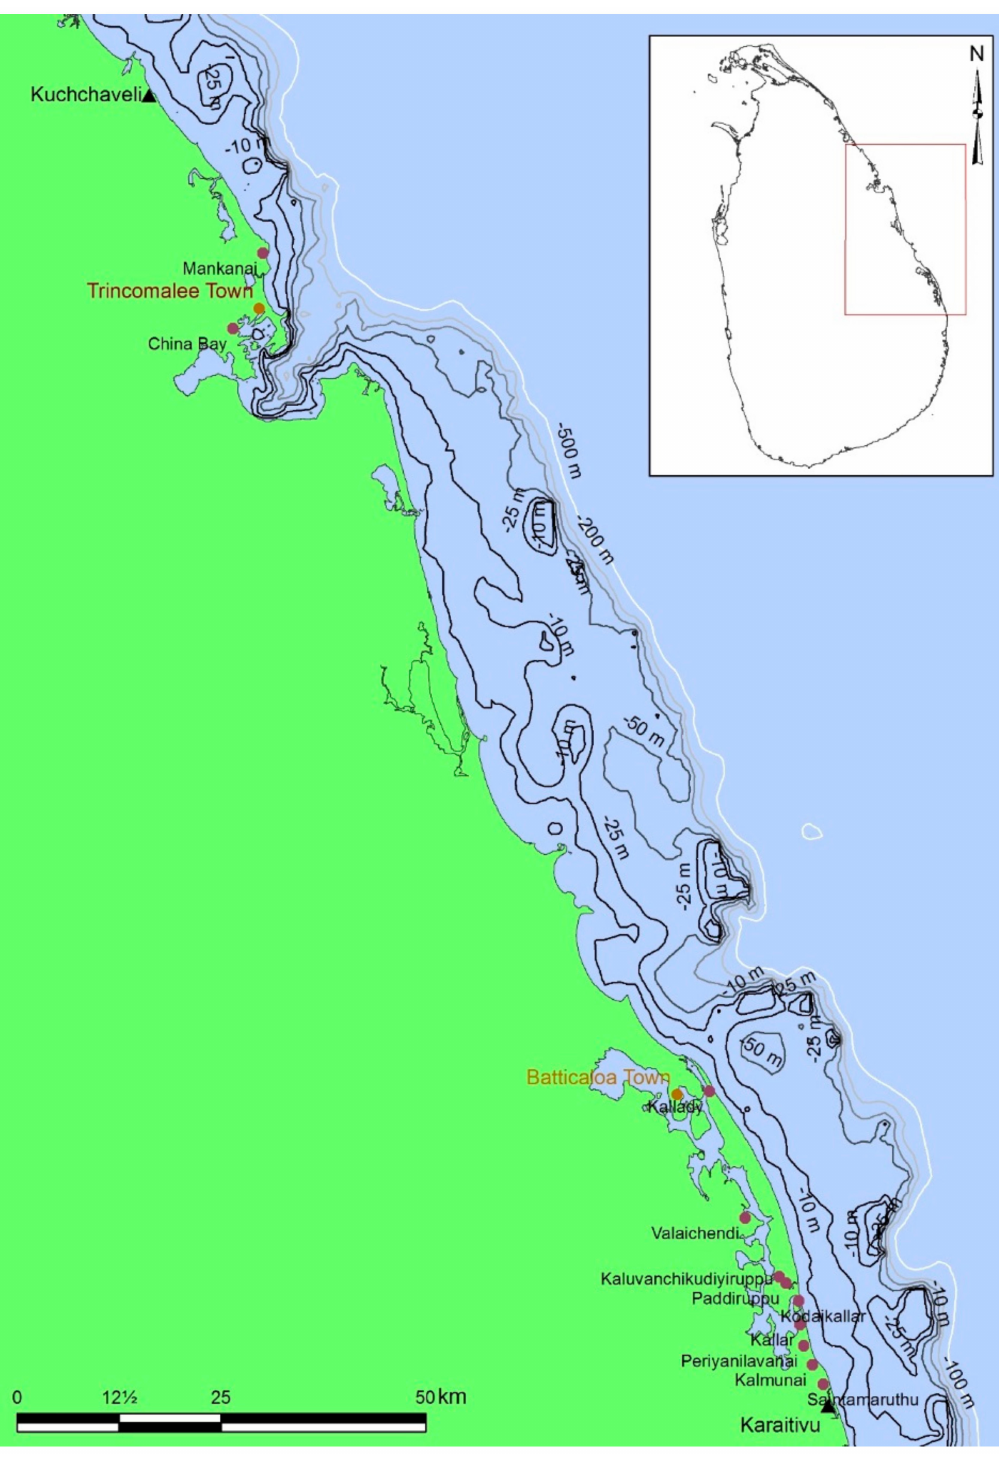
Figure 1. Study area: Trincomalee and Batticaloa district coastlines, along the east coast of Sri Lanka from Kuchchaveli to Karaitivu (~200